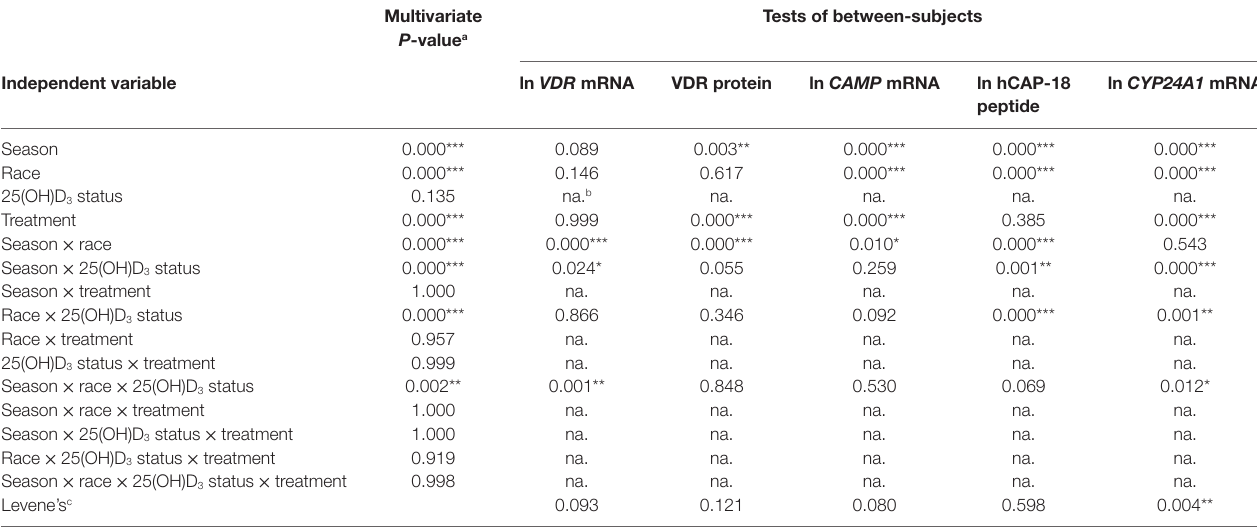
TaBle 2 | Multivariate main and interaction effects of season, race, 25(OH)D 3 status, and treatment on the functional variables marking TLR2/1 vitamin D receptor (VDR)-mediated signaling. Multivariate P -value